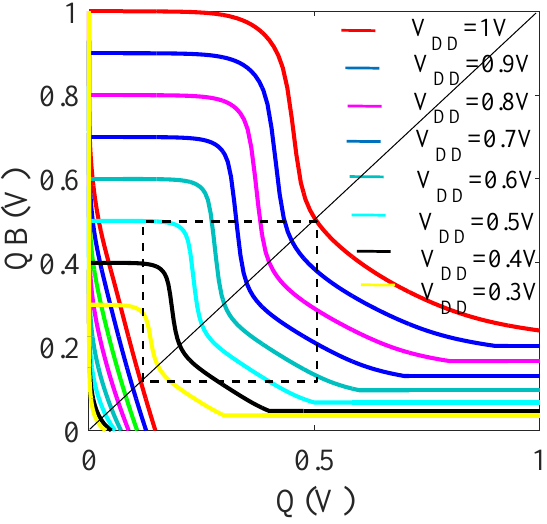
Figure 24. Write stability analysis for the proposed SRAM